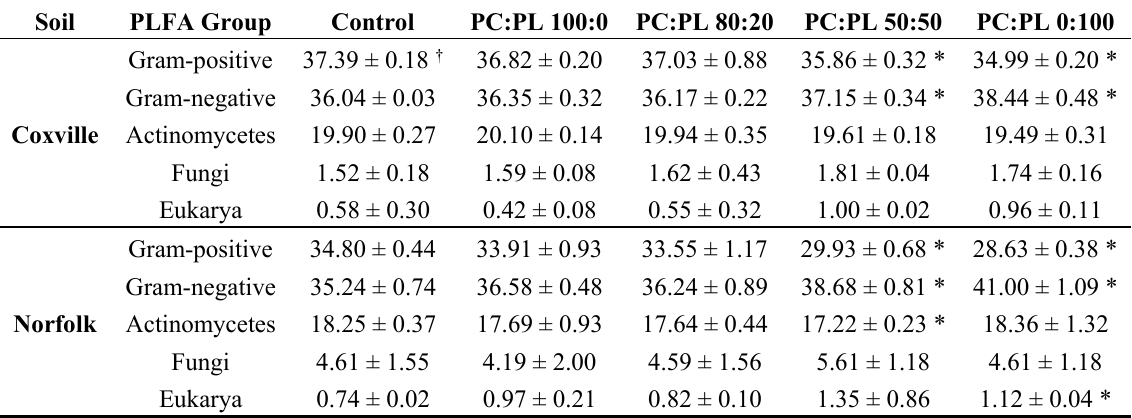
Table 3. Relative abundances (% of total) of PLFA groups in biochar treatments. Soil